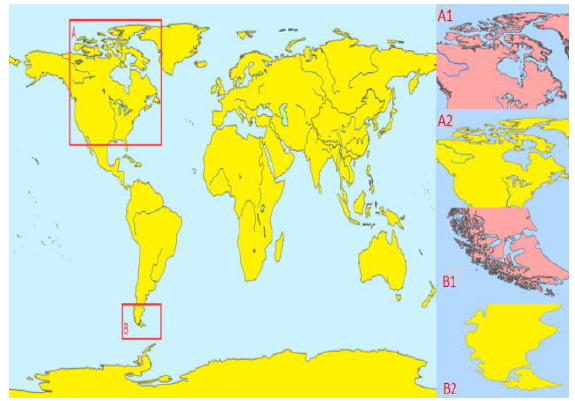
Figure.12 After Water System